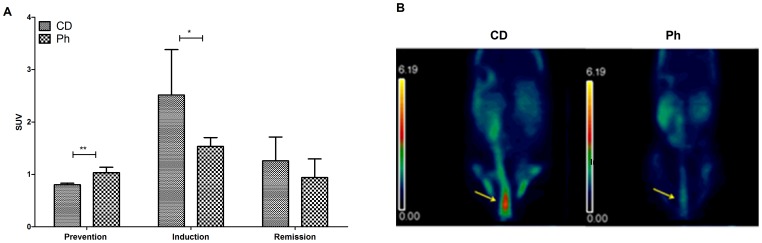
Assessment of acute colitis and evaluation of the response to Ph. 18F-FDG micro PET.A. Quantification of 18F-FDG uptake (SUV) in the distal colon of Balb/c mice fed with CD and Ph. Analysis were repeated on the same mice at day 14th, after CD and Ph (respectively n = 5; n = 5, **P = .0014), at day 24th, the last of the ten days of DSS colitis induction (CD n = 5; Ph n = 5, ns), at day 38th, fourteen days after the end of the DSS administration (CD n = 4; Ph n = 5, * P<.05). B. Representative PET image showing different 18F-FDG accumulation in the distal colon (yellow arrows) of Balb/c mice fed with CD (left image) and Ph (right image) at the end of induction. On the left of each images the SUV chromatic scale, from 0.00 to 6.19, is reported.